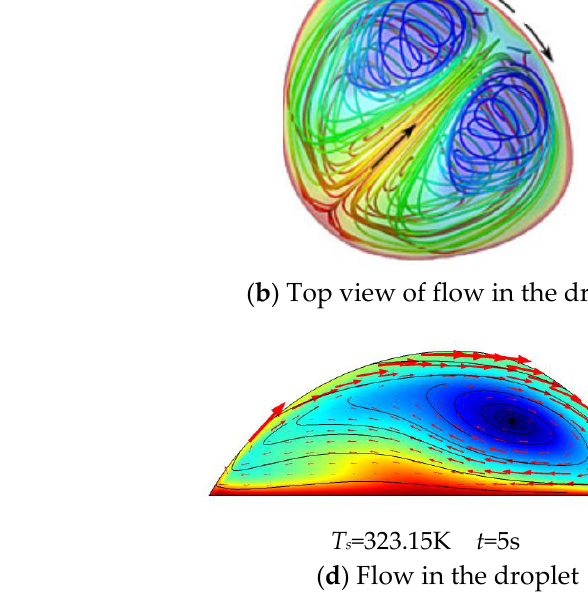
Figure 7. A comparison of the results from Sáenz et al.’s work [22] ( a,b ) and the present simulation ( c , d ). (The results of the present 2D simulation work, showing a lower temperature ( c ) and a single vortex ( d ) resting on the right side of the droplet, which were similar to Sáenz et al.’s work ( a , b ).